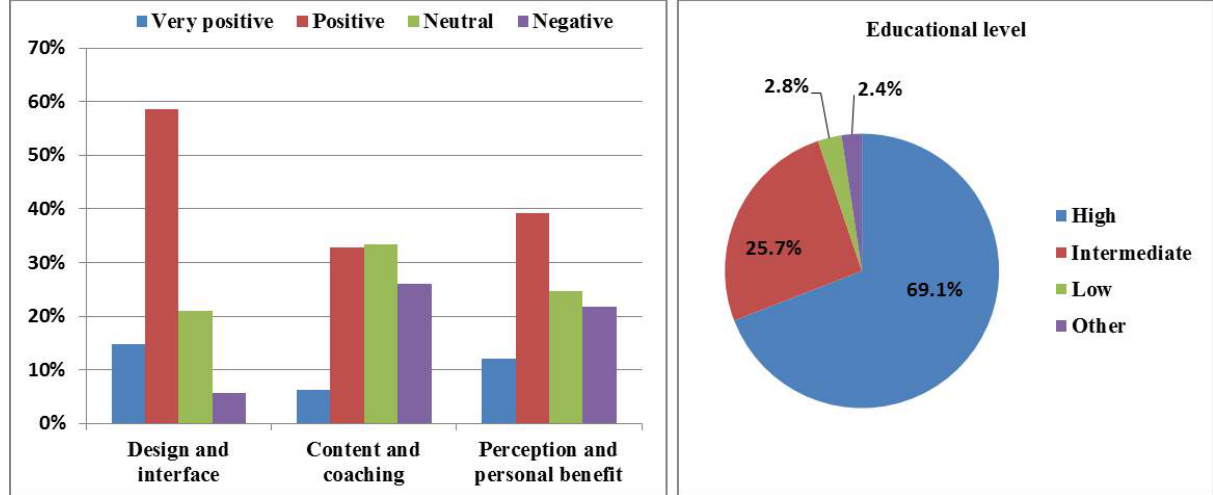
Figure 2. Results of the evaluation of usability based on 357 evaluation forms. Usability of the Smarter Pregnancy program was subdivided into three program characteristics (left) and by participant educational levels